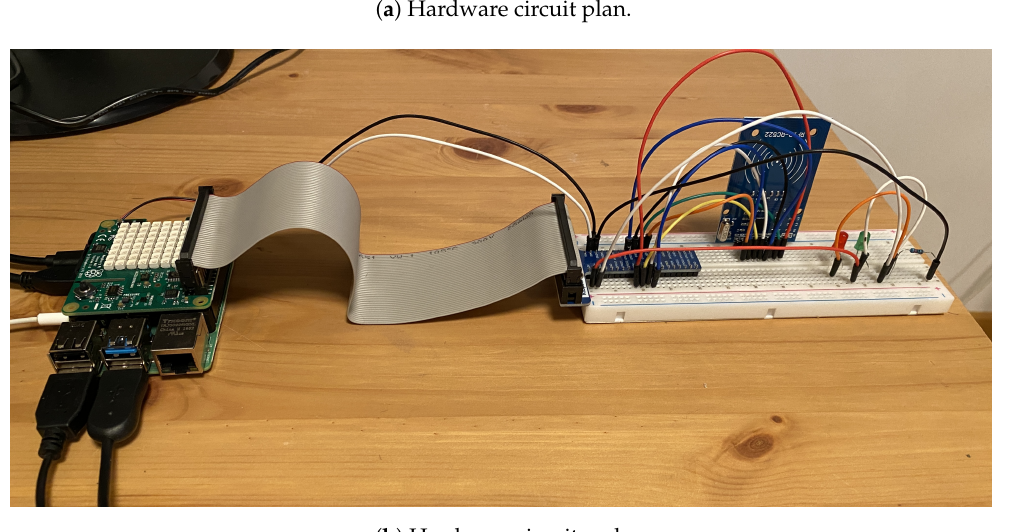
Figure 2. RFID LEDs Raspberry Pi Visualization